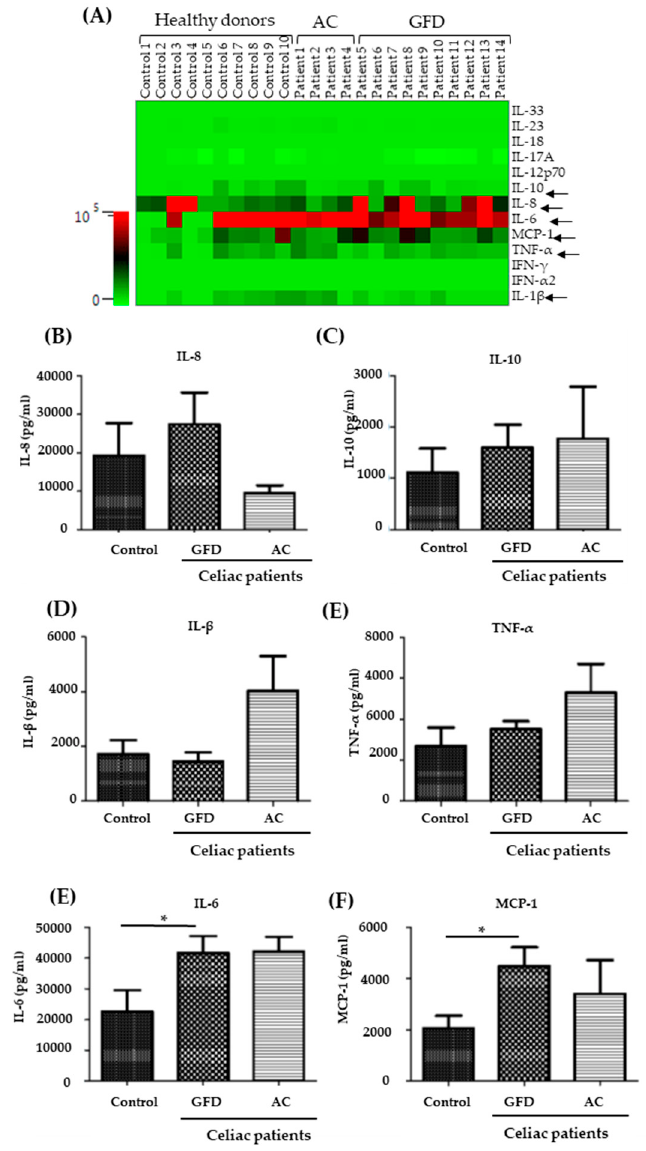
Figure 4. Increased levels of pro-inflammatory cytokines in the supernatant of monocytes derived from celiac disease patients. ( A ) PBMCs were isolated from 10 controls, 10 GFD, and 4 active CeD patients, and monocytes were sorted using CD14 MACS MicroBeads. Subsequently, cells were kept in the incubator for 24 h in the presence of GM-CSF (10 ng / mL). Supernatants of monocyte cultures were collected and cytokine levels were determined. Data are illustrated as a heat map revealing color-coded concentrations of cytokines (green: low concentration; red: high concentration). ( B – F ) Results for individual cytokine measurements are shown: Interleukin- (IL-)8, IL-10, IL-1 β , TNF- α , IL-6, and MCP-1. Mean values ± SEM are shown. Mann–Whitney test: *, p < 0.05 .